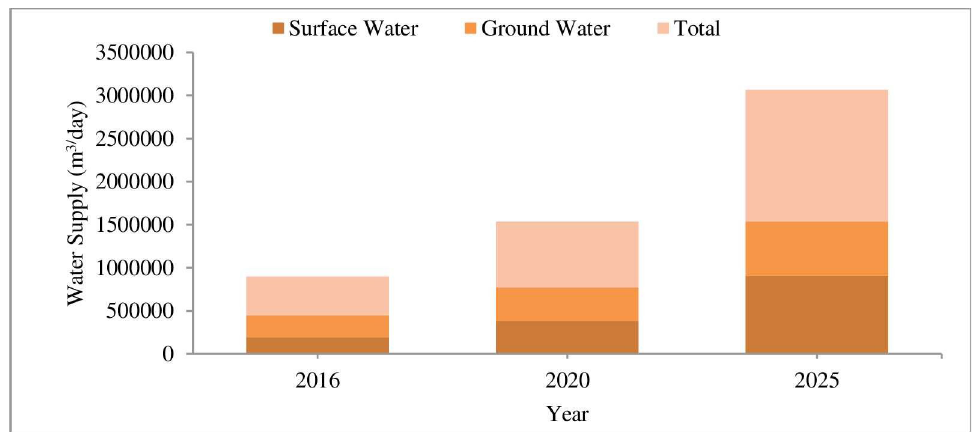
Fig 3. Water supply capacity from surface and groundwater source [44]. The total existing and planned water supply of Addis Ababa in 2025 will be 0.56 BCM (1534247 m 3 /day) and this value is expected to reach 2030 and 2050 when there is no addition water supply